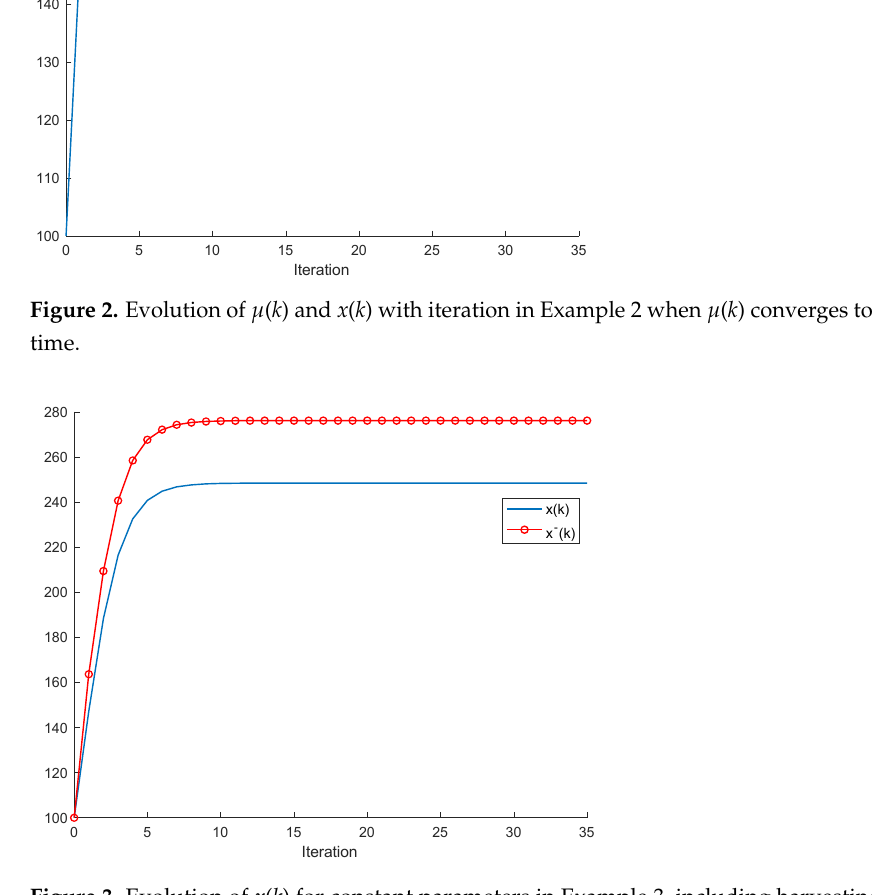
Figure 4. Evolution of x ( k ) for constant parameters in Example 3, while no harvesting nor independ- ent consumption is considered.